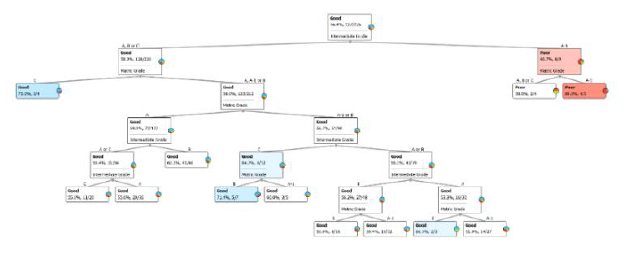
Fig. A1. Classification Tree with pre-university grades